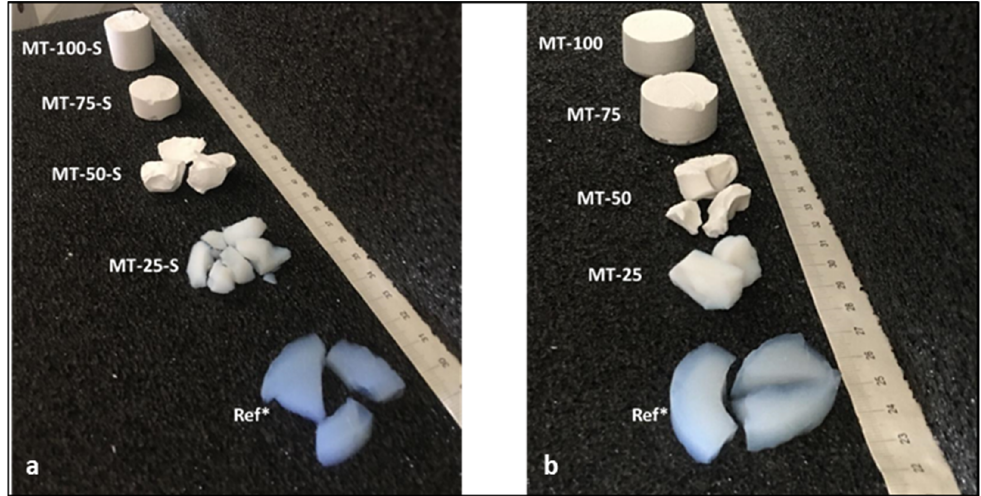
Figure 8. Physical appearances of the ( a ) silylated and ( b ) non ‐ silylated silica xerogels (Ref*: neat